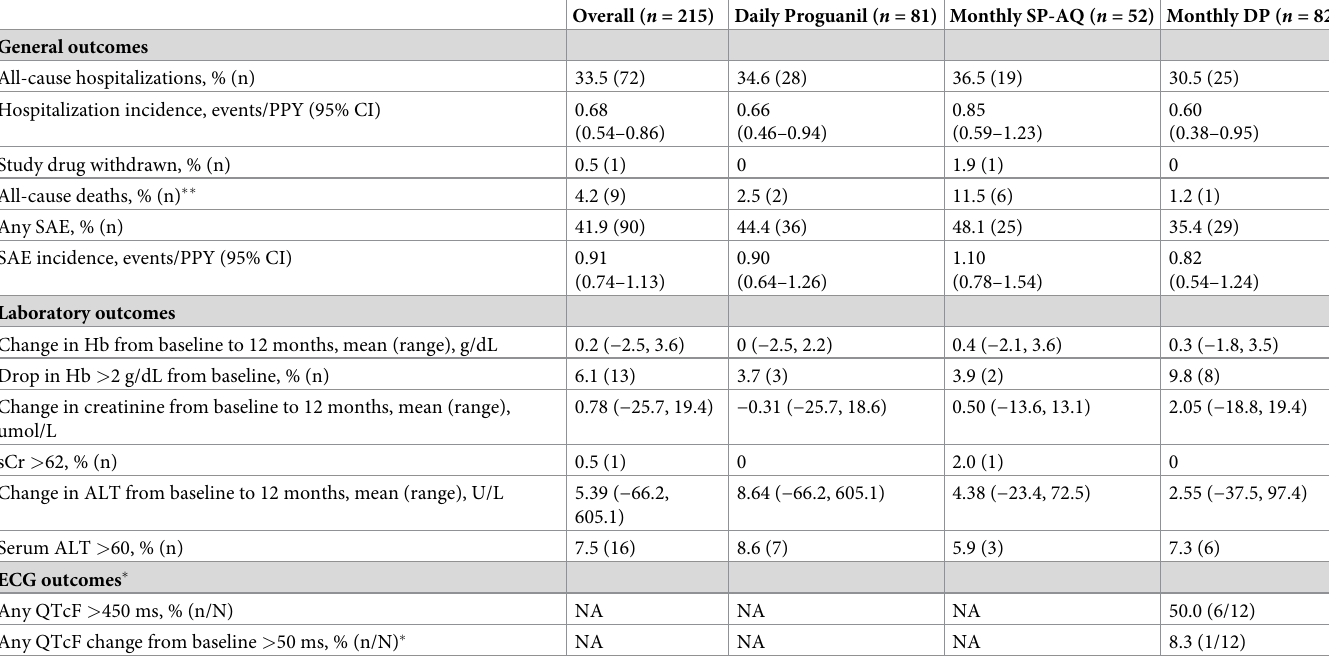
Table 4. Safety outcomes and SAEs in ATP